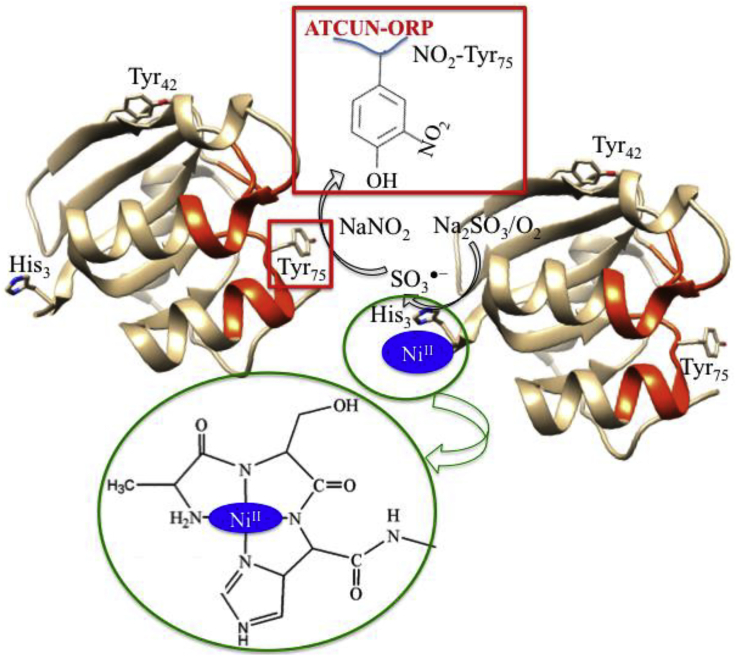
Nitration of Tyrosine in ORP by Ni-ATCUN in Presence of Na2SO3/NaNO2/O2 (Modified from Maiti et al., 2019)The drawing was adapted from the crystal structure of apo-ATCUN-ORP [PDB: 2wfb, Najmudin et al., 2009].